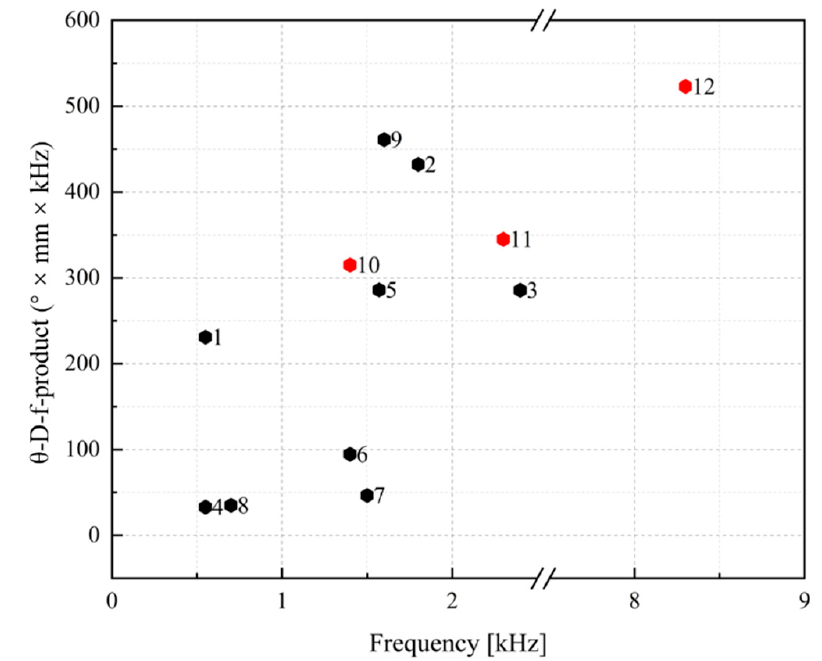
Figure 11. Comparison of MEMS mirrors for LiDAR application. Mirror I-1 , Mirror II-1 and Mirror II-2 are represented by 10, 11 and 12, respectively, in this work. 1 = [12], 2 = [29], 3 = [33], 4 = [34], 5 = [35], 6 = [36], 7 = [37], 8 = [38], 9 = [39], 10 = Mirror I-1 , 11 = Mirror II-1 , 12 = Mirror II-2.